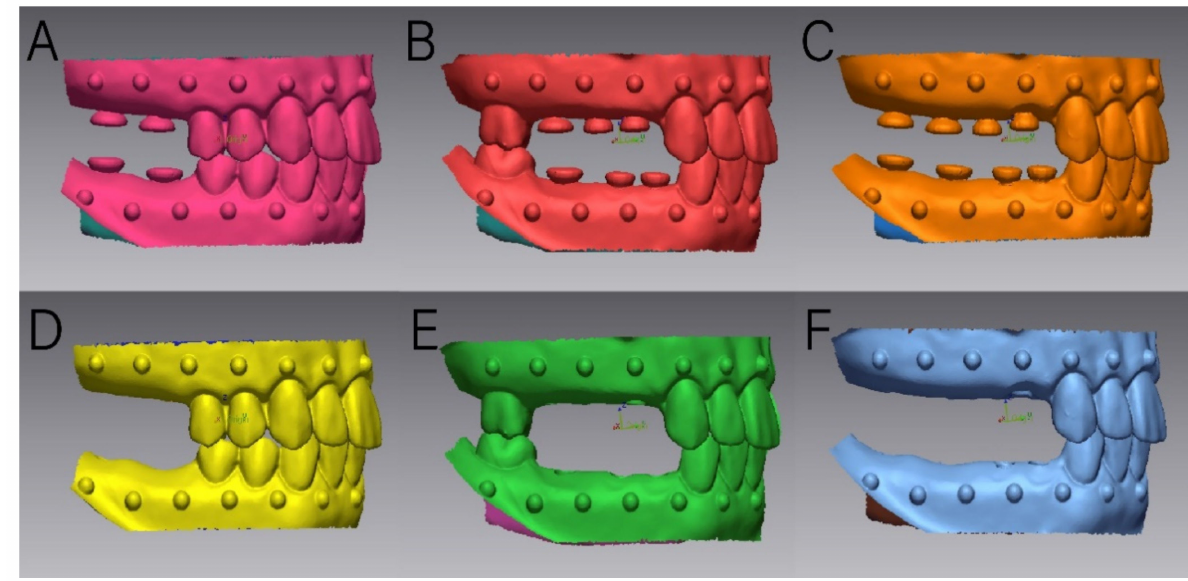
Figure 2. Images of the experimental models. HA groups and non-HA (NHA) groups are placed as follows: ( A ) HA-2, ( B ) HA-3, ( C ) HA-4, ( D ) NHA-2, ( E ) NHA-3, and ( F )